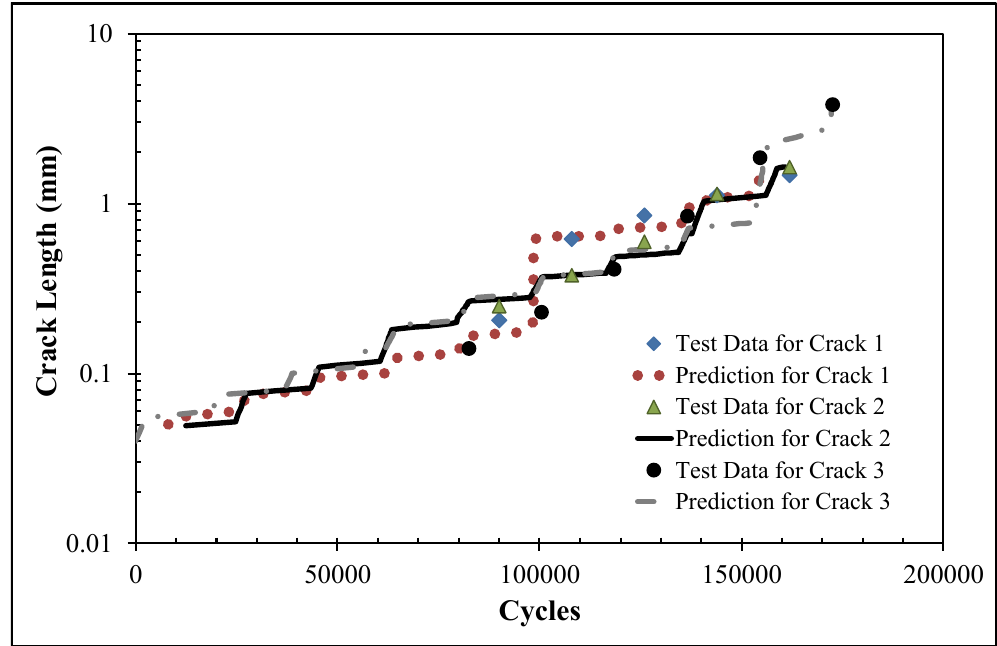
Figure 21. Measured and computed crack length histories for cracks 1–3 in specimen DNHS ‐ 1 ‐ 12.